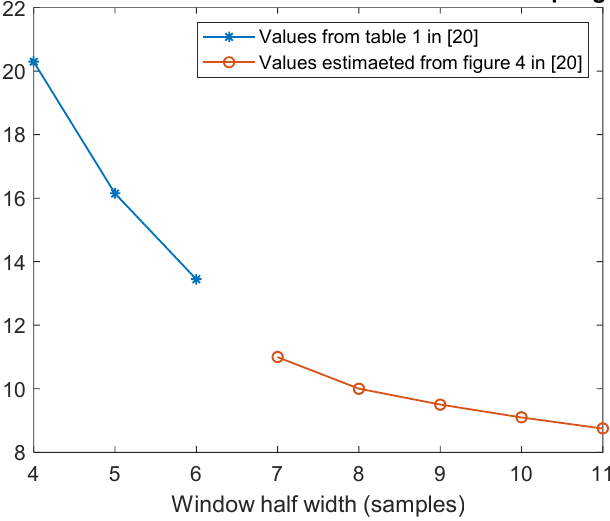
Figure 1. The 3 dB bandwidth for SG applied to a signal sampled at 100 Hz, as a function of window length. Data from [20].